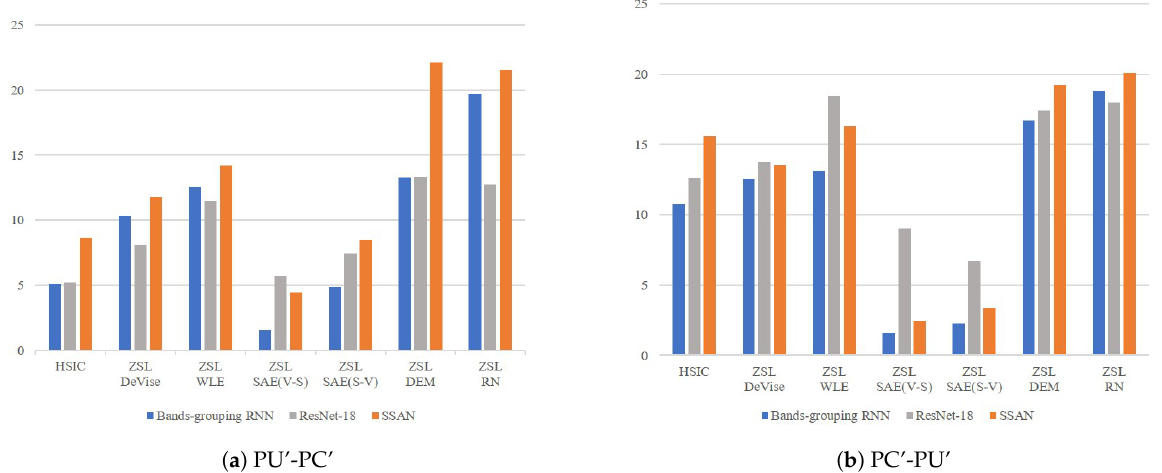
Figure 13. The top-1 accuracy of the ordinary hyperspectral classification and the comparative zero-shot learning methods in case 5 PU’-PC’ and case 6